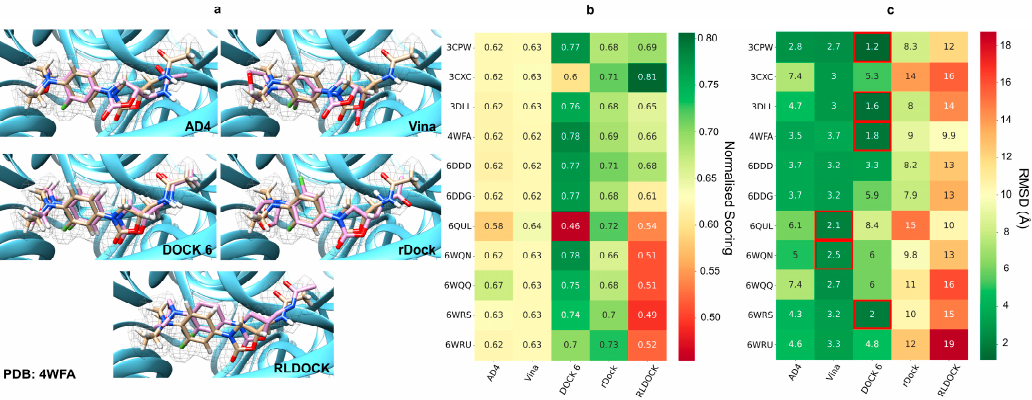
Figure 3. Comparison of the redocking performance for the linezolid. ( a ) Examples of results produced when redocking linezolid to its native crystal structure (PDB: 4WFA). The native ligand pose is beige, the selected redocked ligand is pink, and the 2 Å mesh of the electron density map is grey. ( b ) The average scoring for each program is displayed in a heatmap using normalized scoring values, showing all linezolid ligand crystal structures. ( c ) The average RMSD for each program is displayed in a heatmap, showing all linezolid ligand crystal structures. The crystal structures that scored at or below 2.5 Å are indicated by red squares. Figure 3a was visualised through UCSF Chimera (v 1.15)